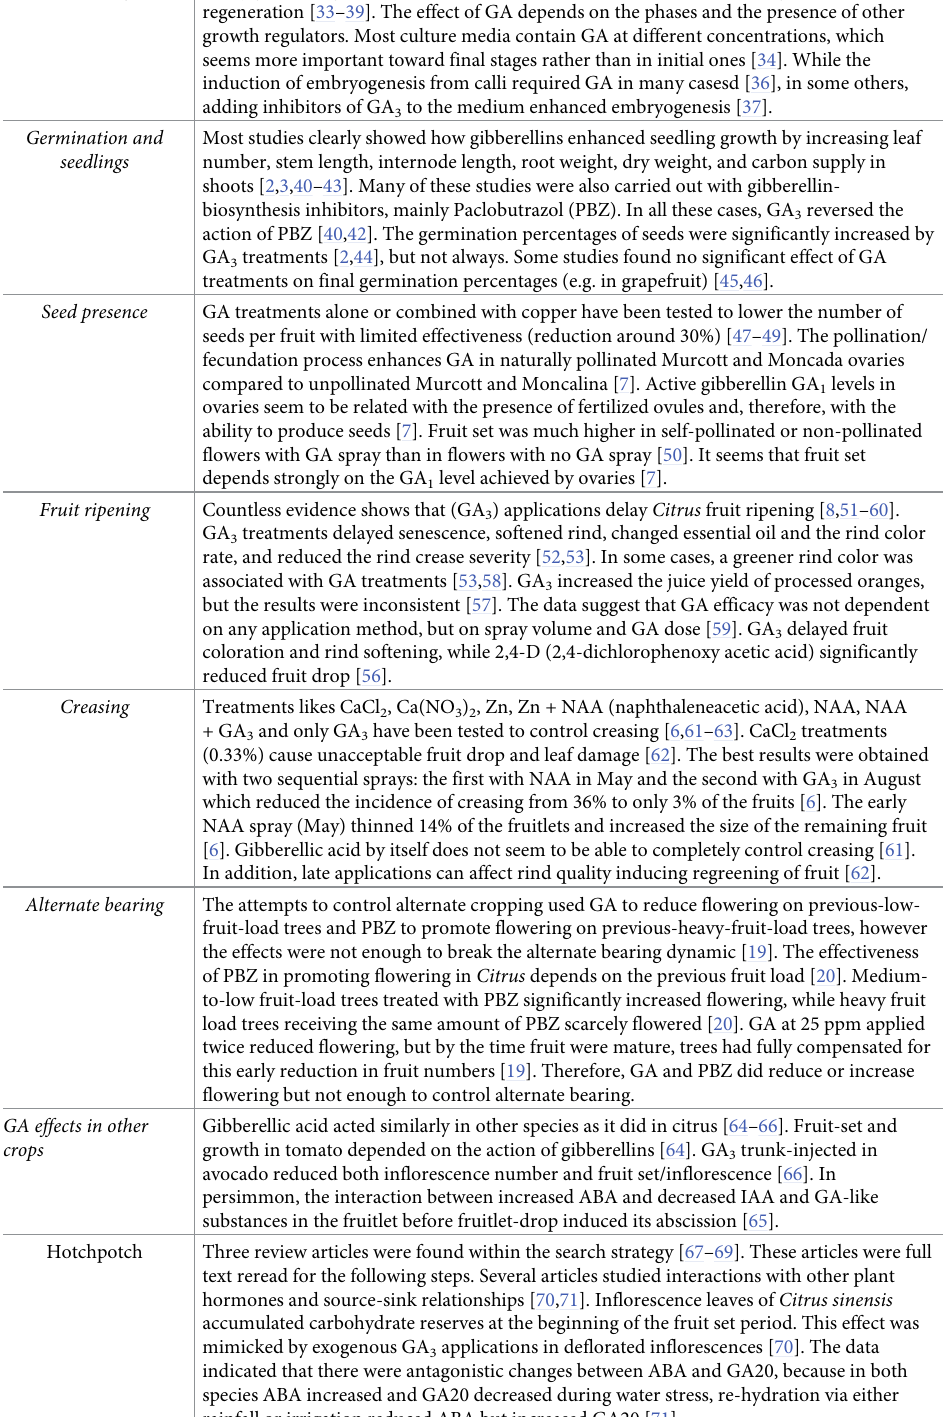
Table 3. Summary of the initial data extraction per process. Effect of GA on other Citrus development processes. Flowering, Fruit set and yield, and pest and disease groups are not